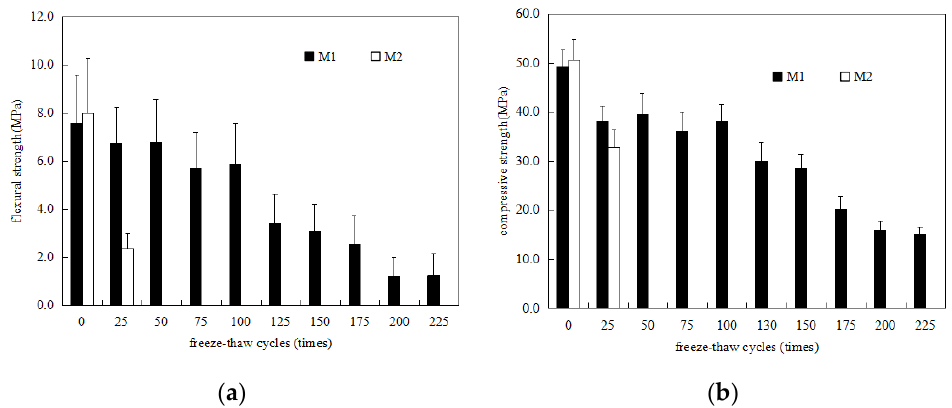
Figure 2. Strength changes in MKPC mortar specimens and P.O mortar specimens in a 5% Na 2 SO 4 solution freeze–thaw environment. ( a ) Flexural strength; ( b ) compressive strength.